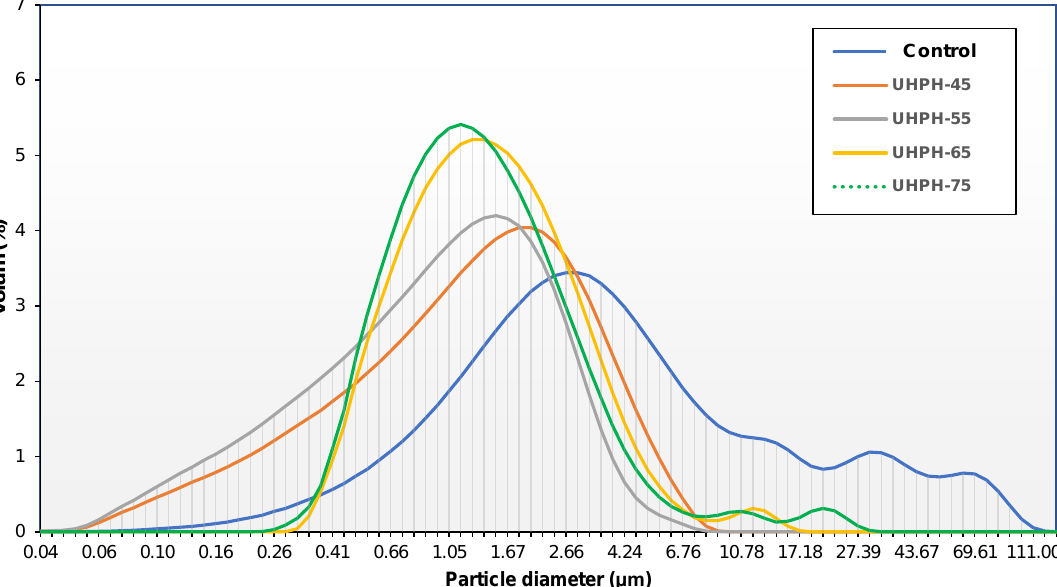
Figure 2. Particle size distribution curves of untreated (control) and ultra-high-pressure-homogenized fish broths at 300 MPa at different inlet temperatures (45, 55, 65, and 75 °C).